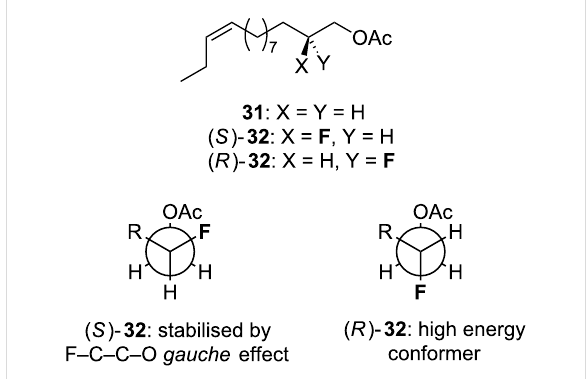
Figure 7: The insect pheromone 31 and fluorinated analogues ( S )- 32 and ( R )- 32 . The proposed bioactive conformation is shown in Newman projections.